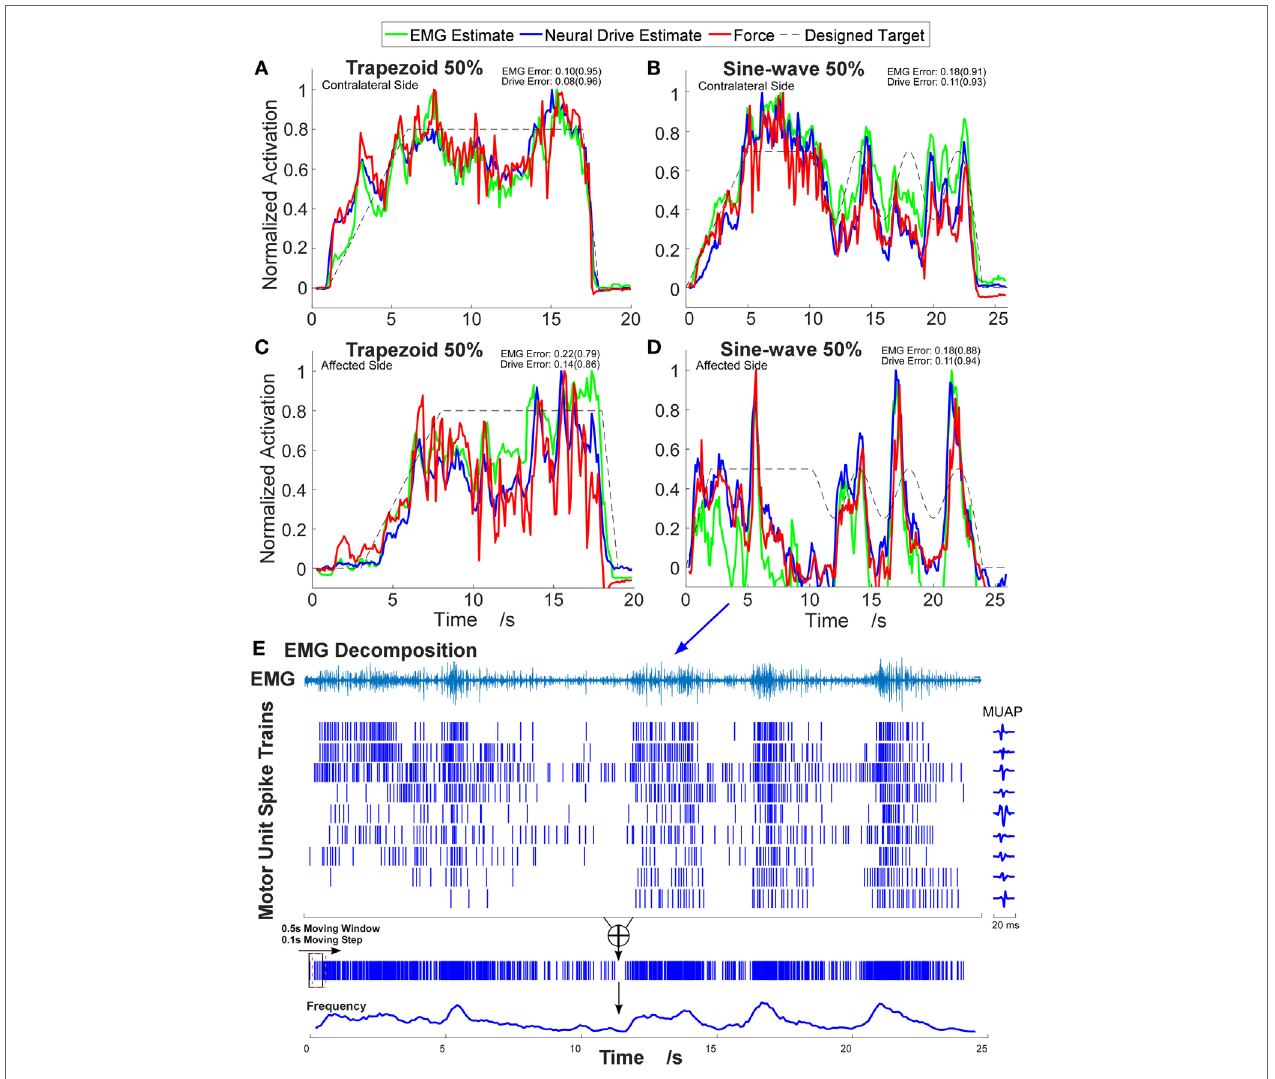
FIgURe 2 | Example time-series plots of four different contraction tasks. (a,B) Contralateral side. (C,D) Affected side. The corresponding root-mean-square errors (RMSEs) are presented and the correlation coefficients are shown in brackets. (e) Illustration of the decomposition results and the neural-drive-based estimation from trial (D) . One channel electromyogram (EMG) signal with highest root-mean-square value is shown, and the corresponding waveforms of motor unit action potentials (MUAPs) in that channel are